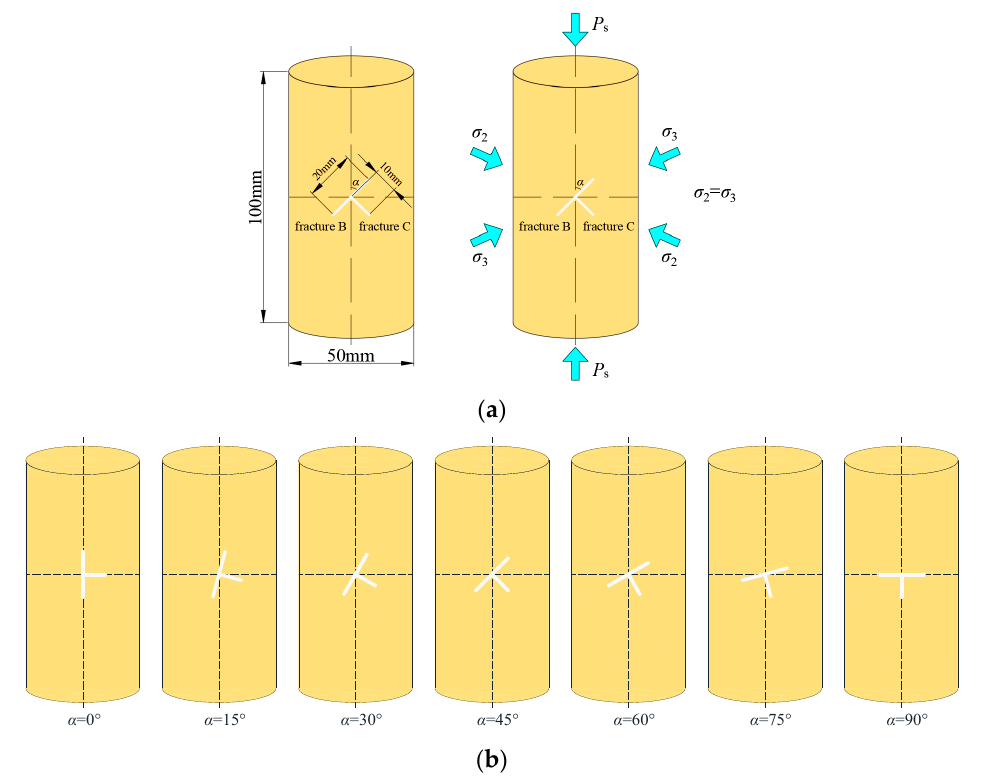
Figure 1. Schematic diagram of the T-shaped fractured sandstone specimen model: ( a ) Geometry and loading conditions, ( b ) Specimens with di ff erent fracture inclination angles.